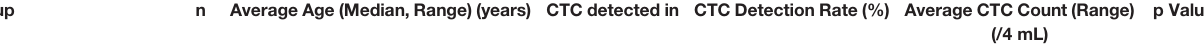
FIGURE 1 | CTC are correlated with BC patients ’ cancer stage, tumor size and lymph node involvement and can be used to distinguish BC patients from patients with benign tumors and healthy female. (A) Immuno fl uorescent staining of a captured CTC, indicated by the yellow arrow. CTC is de fi ned as a DAPI (blue) positive, PanCK-FITC (green) positive and CD45-PE (orange) negative cell, while a white blood cell is indicated by the white arrow as a DAPI positive, CD45-PE positive and PanCK-FITC negative cell. (B) CTC enumeration can differentiate BC patients from patients with benign tumors and healthy females (both p < 0.0001). (C) CTC enumerations are correlated with BC patients ’ cancer stage (p = 0.0007), tumor size (p = 0.0015) and lymph node involvement (p = 0.0034). More CTC are found in patient with bigger tumors and more lymph node involvement as shown in (D, E) . **** indicates P < 0.0001, *** indicates 0.0001< P < 0.001, while ** indicates 0.001 < P < 0.01. TABLE 1 | Correlations of CTC with patients ’ pathoclinical characteristics. Group